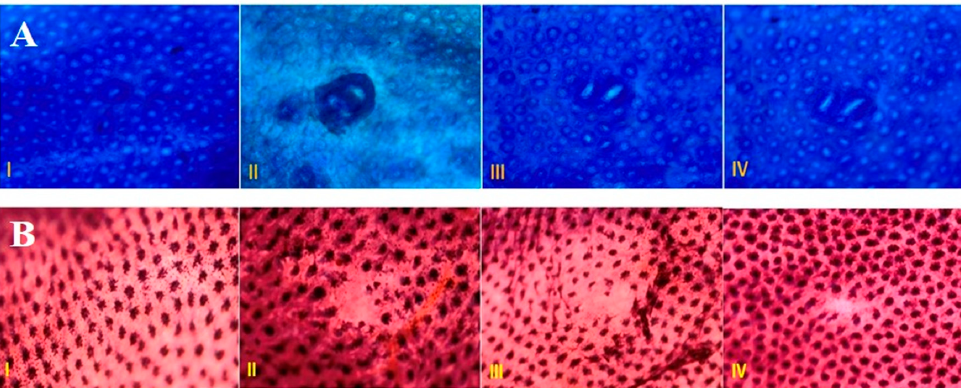
Figure 3. Effect of piperine treatment on ACF and MDF. ( A ) Piperine attenuates ACF per rat colon in DMH administered groups as compared to tumor group. ACF visualized by methylene blue (MB) staining are detectable under microscope. The colons here were opened and stained with high iron diamine (HID) and Alcian blue (AB) as we can see in the picture. ( B ) Piperine attenuates MDF per rat colon in DMH administered groups as compared to tumor group. MDF are the dysplastic crypts lacking mucin formation found in the colons of chemical carcinogen rodent studies. The colons here were opened and stained with high iron diamine (HID) and Alcian blue (AB) as we can see in the picture ( n = 10).